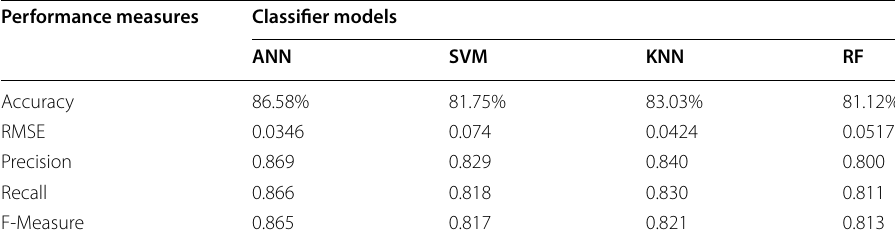
Table 5 Performance of ML models on Urdu dataset Performance